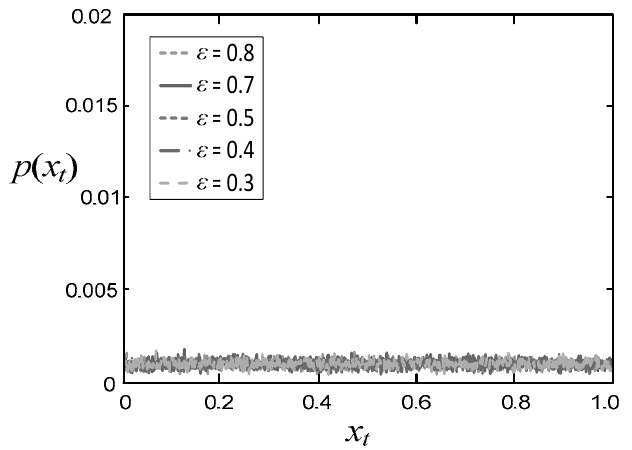
Figure 9. The simulation results of the improved CML based on the logistic map. To improve the security, we discard both the first 64 outputs. Because the keystream includes the binary sequences, the CML output is the real number. It needs the output transformation. The output transformation is defined by Equation